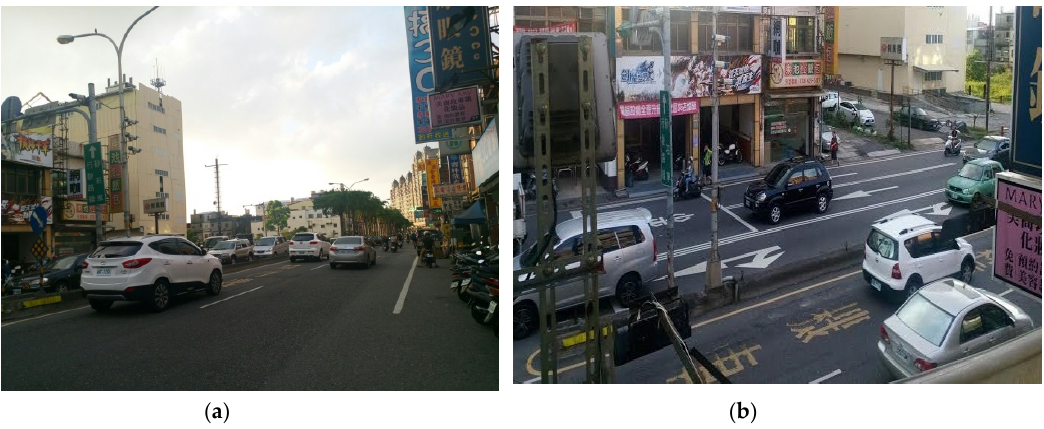
Figure 12. Urban road site for traffic experimental tests. ( a ) Road site viewed fromthe sideway; ( b ) Road site viewed from the deployed TMRDs.